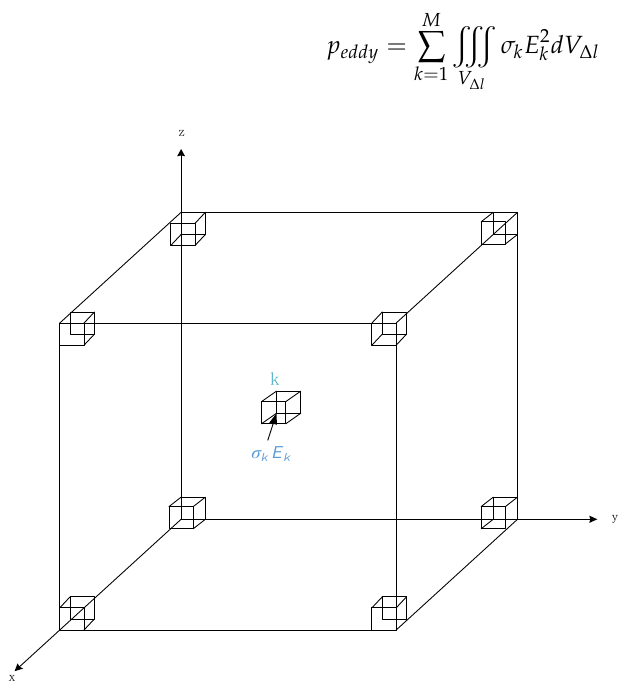
Figure 13. Solution diagram.